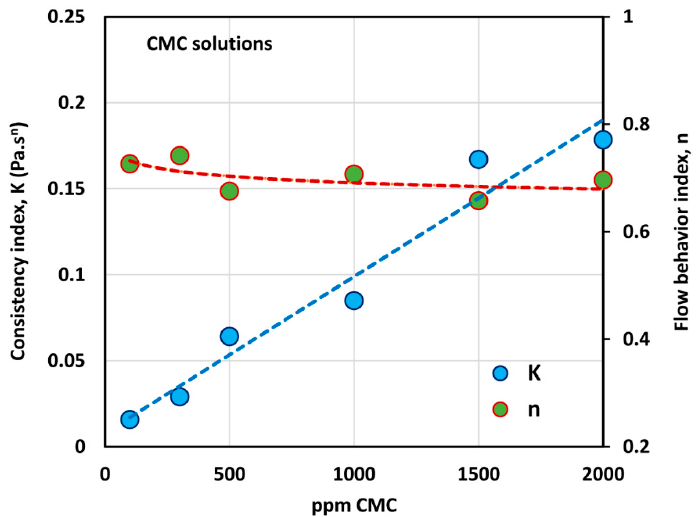
Figure3. Variationsofconsistencyindex, K ,andflowbehaviorindex, n Figure 3. Variations of consistency index, (cid:1837) , and flow behavior index, (cid:1866) , with polymer (CMC) concentration.